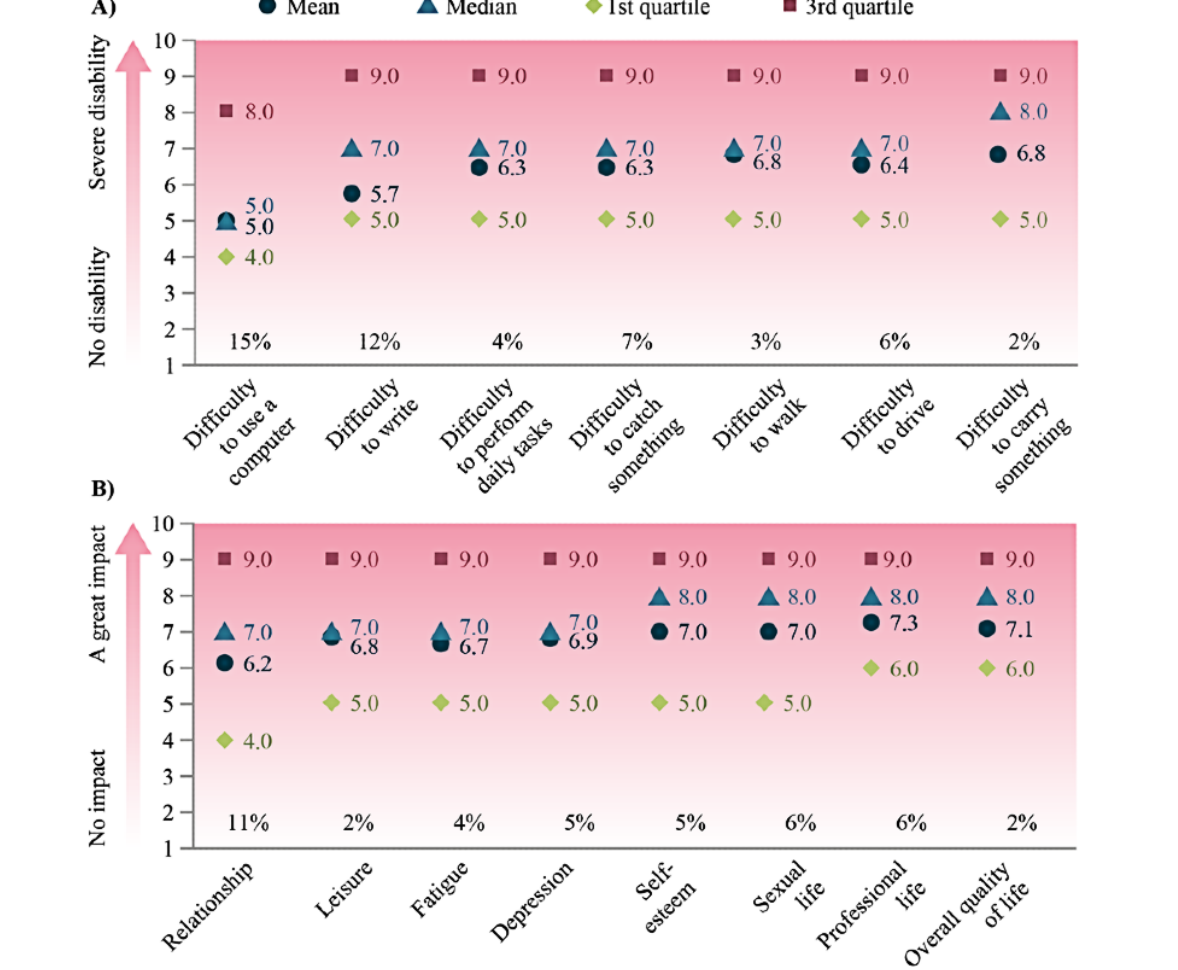
Scores for the impact of spasticity on patients' QoL are shown in Figure 2. All median scores were ≥ 7.0, with professional life,